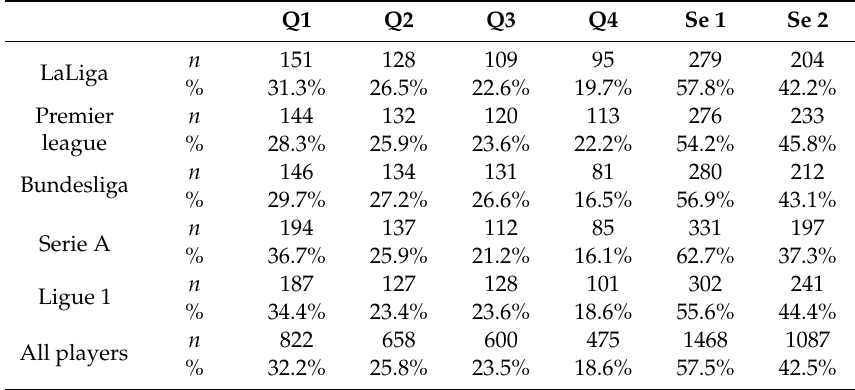
Table 2. Birth date distributions of European league soccer players (2017 / 2018) according to their quartile (Q) or semester (Se) of